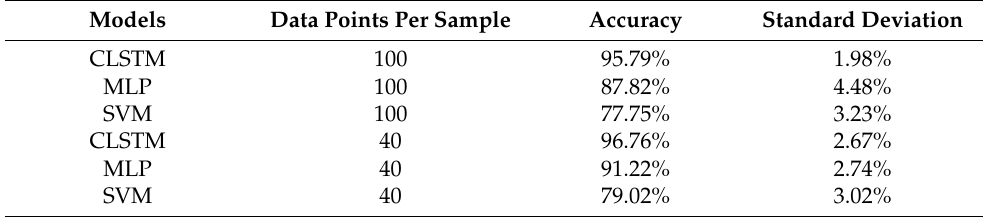
Table 3. Comparison of models’ overall prediction